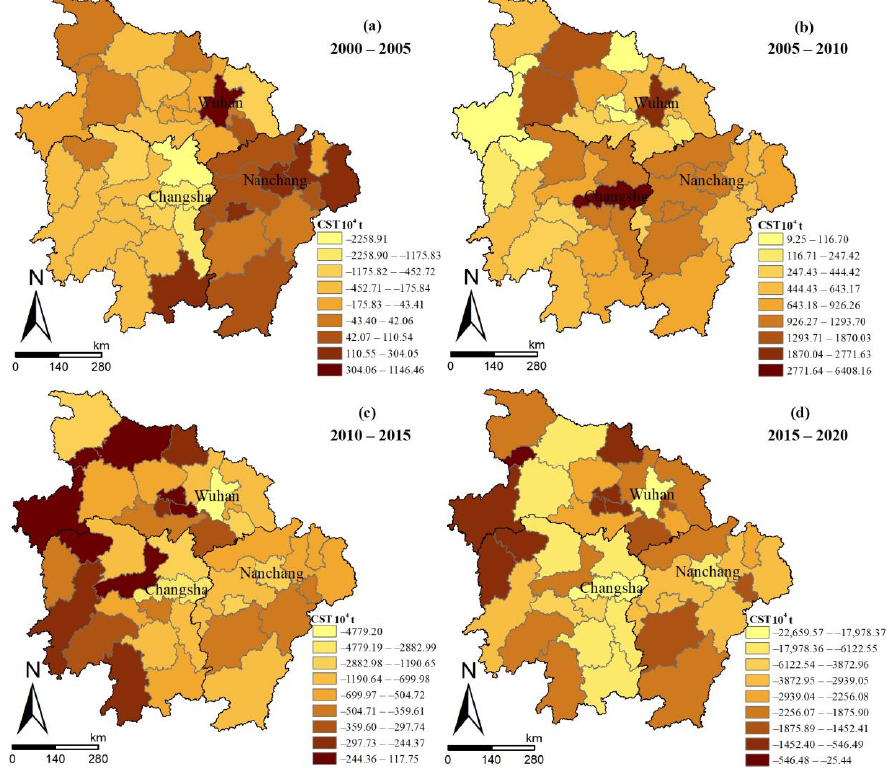
Figure 6. Carbon source transfer in the Middle Reaches of the Yangtze River from 2000 to